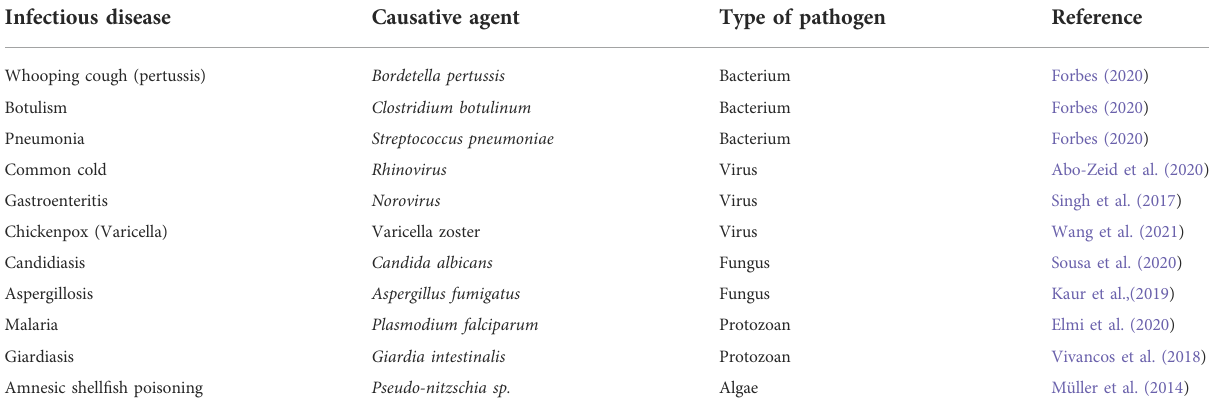
TABLE 1 Infections caused by microbial